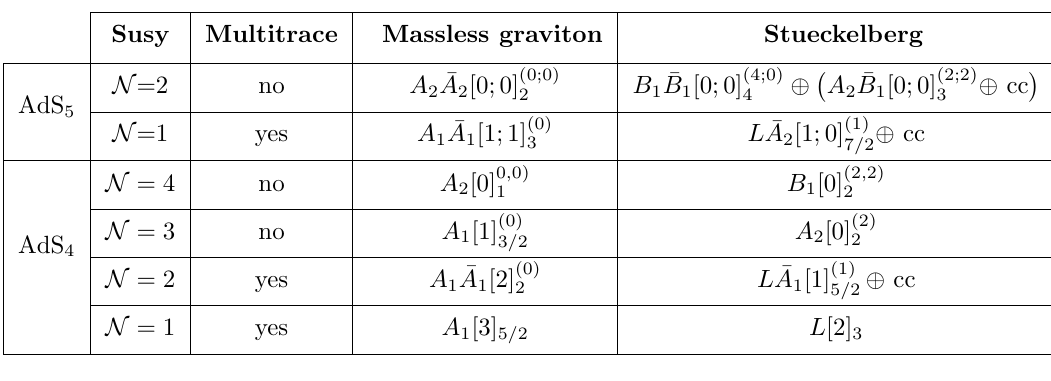
Table 2 . The AdS supergravities for which the graviton multiplet can obtain a mass by gauging a global symmetry of the dual SCFT. The alternative ‘multi-trace mechanism’ is only possible for N Q (cid:20) 4 supercharges. The superconformal algebras are su (2 ; 2 jN ) in d = 4 and osp ( Nj 4) in d = 3. The two right-most columns list the massless graviton and the Stueckelberg multiplets in the notation of ref. [11]. The massive graviton multiplets contain 2 N Q (cid:0) 1 bosonic and 2 N Q (cid:0) 1 fermionic